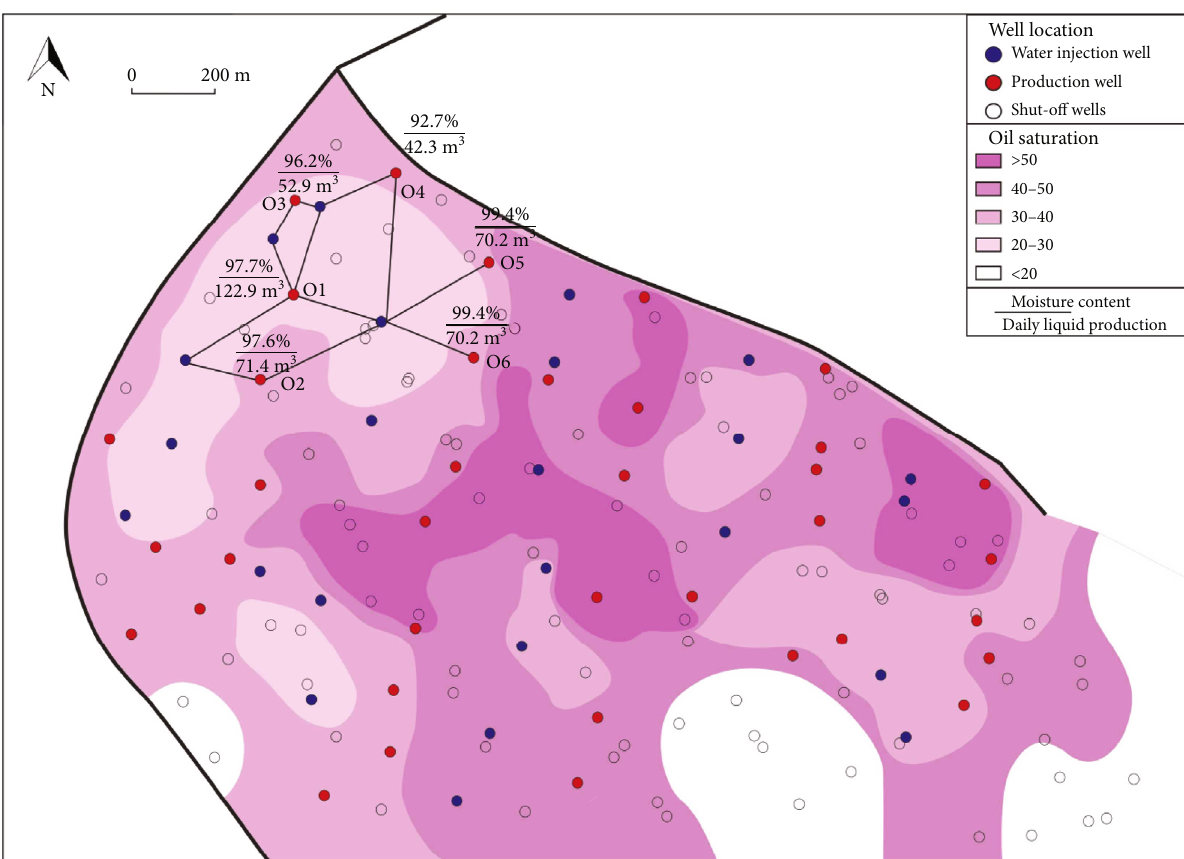
Figure 15: Oil saturation distribution plan of Ng35